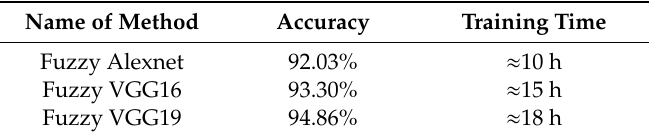
Table 1. Performance comparison.